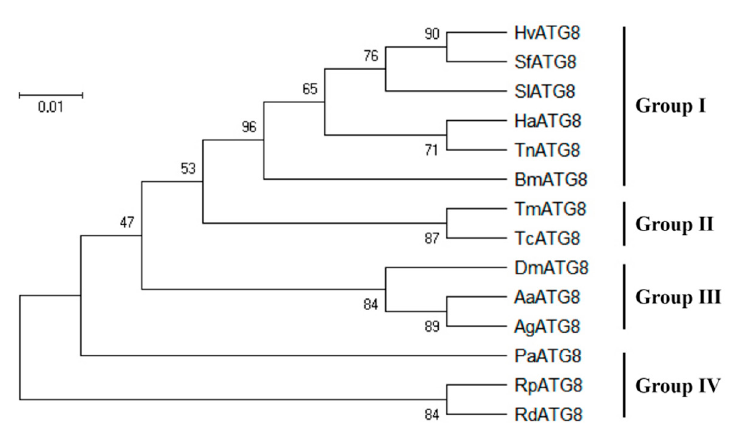
Figure 1. Phylogenetic analysis of HvATG8 . The predicted amino acid sequence of HvATG8 together with 13 selected Atg8 members was aligned, and the phylogenetic tree was constructed using MEGA X. GenBank accession numbers are: SfATG8, S . frugiperda (SPODOBASE: Sf2M09420-5-1); SlATG8, S . litura (JX183217); HaATG8, H . armigera (JQ739159); TnATG8, T . ni (JX183216); BmATG8, B . mori (NP_001040244.1); TmATG8, Tenebrio molitor (KM676434.1); TcATG8, Tribolium castaneum (XP_973073.1; DmATG8, Drosophila melanogaster (NM_167245.2); AaATG8, Aedes aegypti (AY736002.1); AgATG8, Anopheles gambiae (AY736002.1); PaATG8, Periplaneta americana (AB856588); RpATG8, Riptortus pedestris (BAN20392.1); and RdATG8, Recilia dorsalis (ATV91621.1).